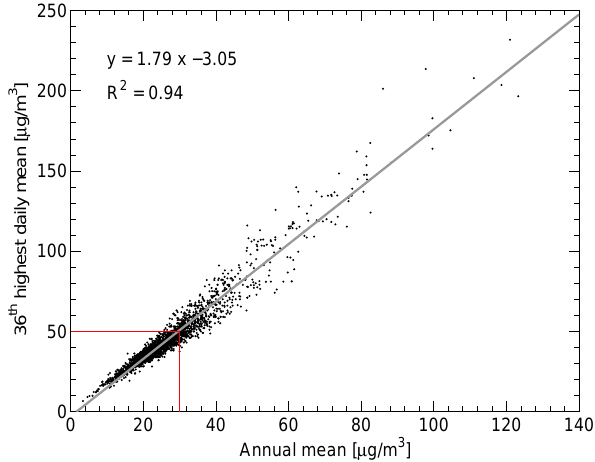
Figure 1. Relation between annual mean concentrations and the 36th highest daily average concentration in AirBase observations (data: all AirBase stations in 2009 with > 80% daily data coverage). The limit on daily exceedances of 50µgm − 3 is well represented by an annual mean limit of 30µgm − 3 .